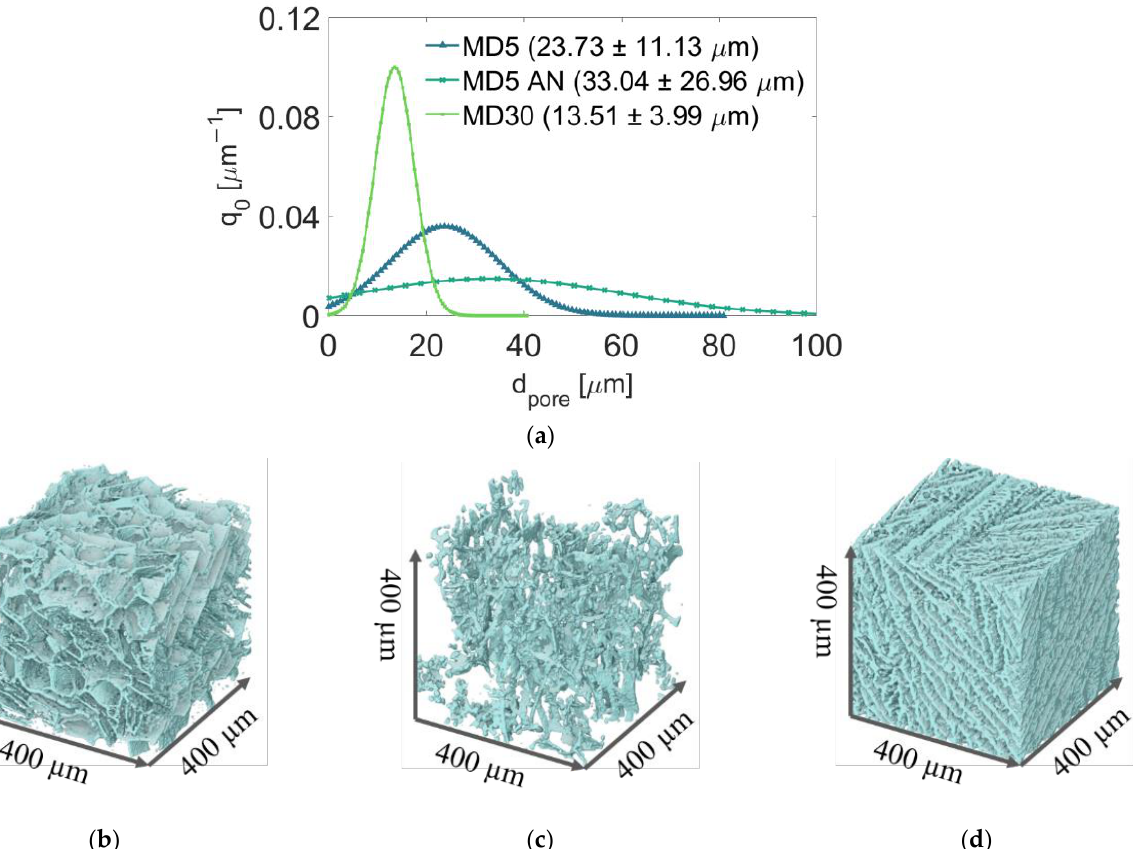
Figure 2. ( a ) Average pore size distribution of each of three samples extracted from different positions; 3D renders of representative parts of samples: ( b ) MD5, ( c ) MD5 AN and ( d ) MD30.